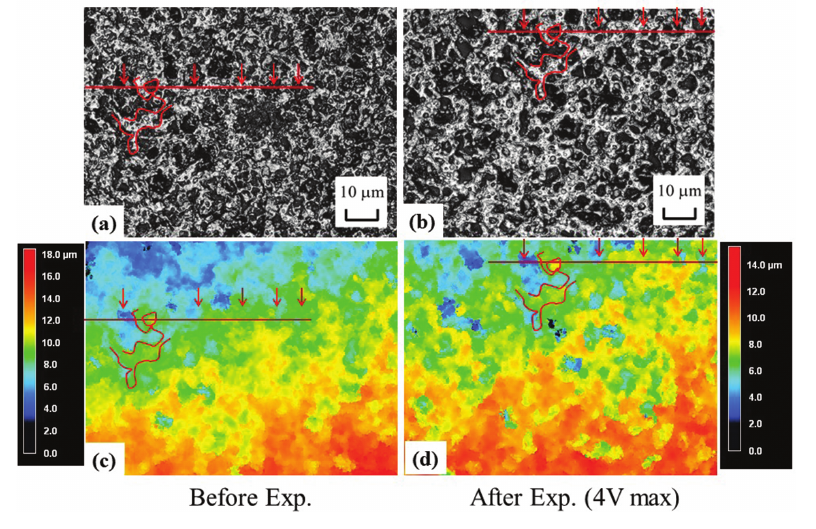
Figure 4: Relationship between voltage and current density at 1,000°C.